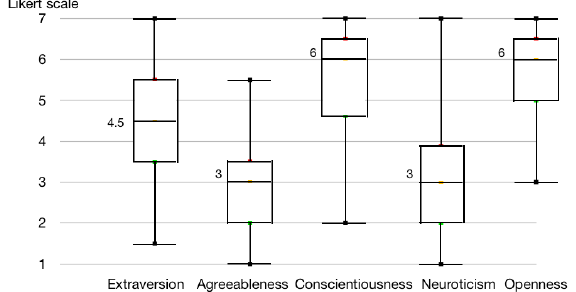
Figure 9: Boxplot of the Big Five personality test